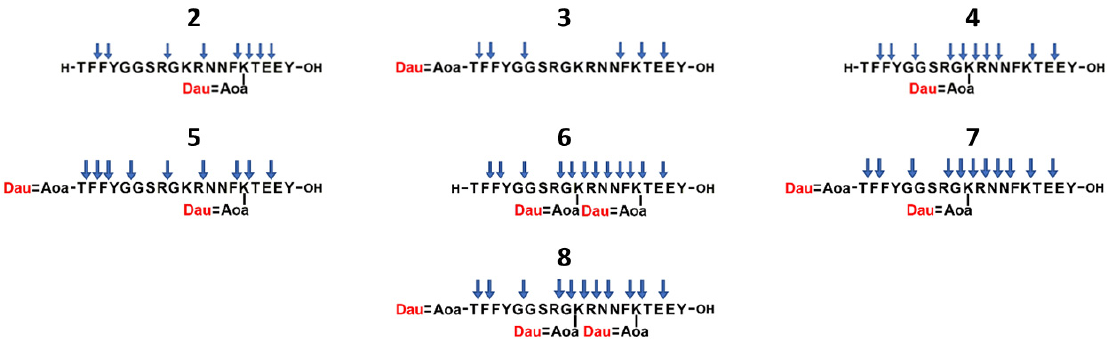
Figure 3. The identified cleavage sites (indicated by blue arrows) of the Angiopep-2–daunomycin conjugates in lysosomal homogenate. The position of the drug molecule is marked with red.